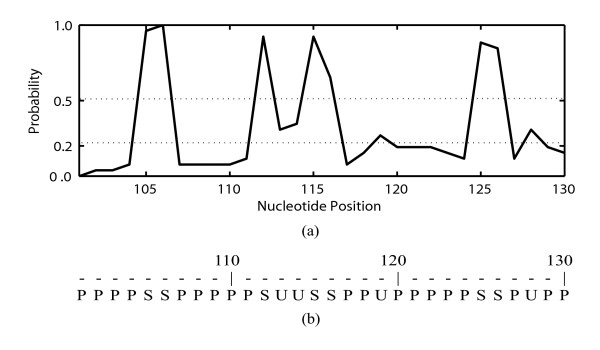
Two representations of multiple predicted structures of rabbit β-globin mRNA (G101-G130). (a) Single-stranded probability profile; (b) 'SUP' representation.